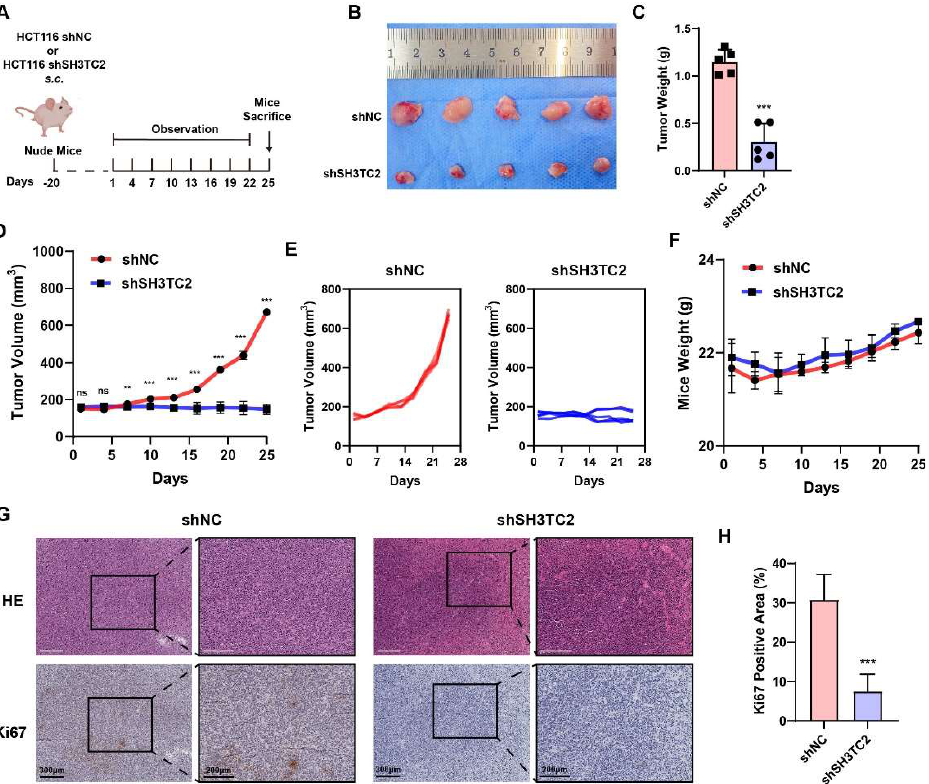
Figure 7. Knockdown of SH3TC2 inhibited tumor proliferation in vivo. ( A ) Scheme of the in vivo experiments. ( B ) Images of tumors resected from the mice at the endpoint. The tumor weight ( C ) and tumor volume ( D ) of the mice. ( E ) The spaghetti curves reveal that SH3TC2 silencing inhibited tumor proliferation in vivo. ( F ) The mouse weight did not change significantly during the experi- ment. ( G ) HE and Ki67 staining of the tumor tissue. ( H ) The Ki67−positive area in the negative con- trol group was significantly higher than that in the shSH3TC2 group, indicating that silencing SH3TC2 inhibited tumorigenesis. Statistical analysis compared the two groups: ns, not significant; **, p < 0.01; ***, p < 0.001.